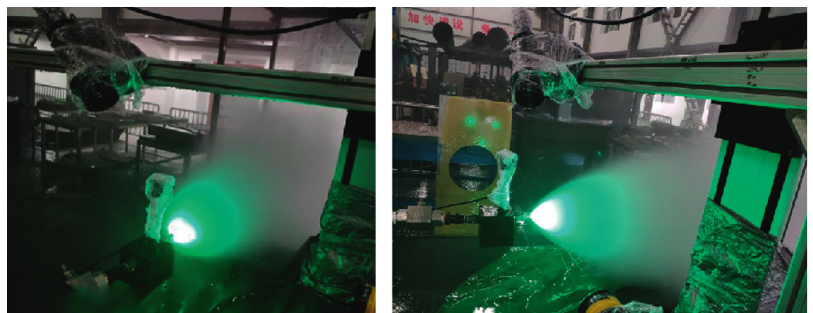
Figure 8: Test site.